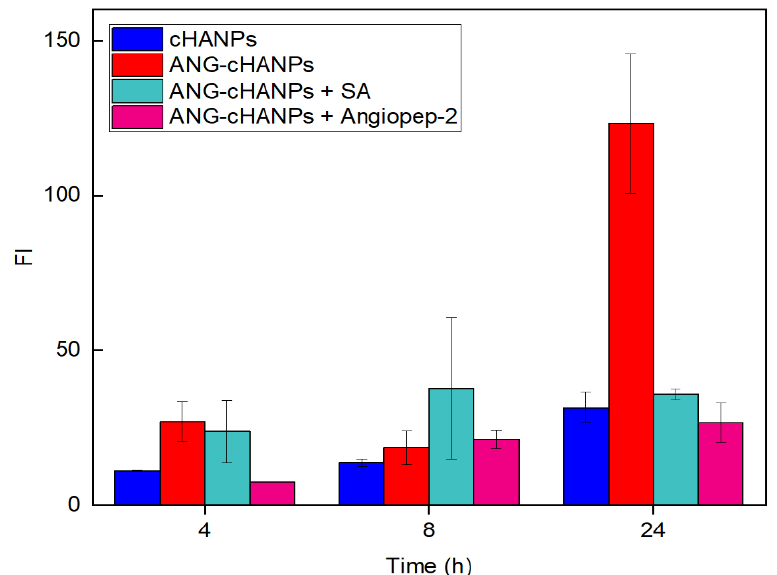
Figure 5. Fluorescent Intensity (FI) of U87 cells after co-incubation with ANG-cHANPs and sodium azide (SA) to deplete cellular ATP, and excess of angiopep-2 for the competitive binding of low density lipoprotein receptor related protein-1 (LRP-1) receptors.